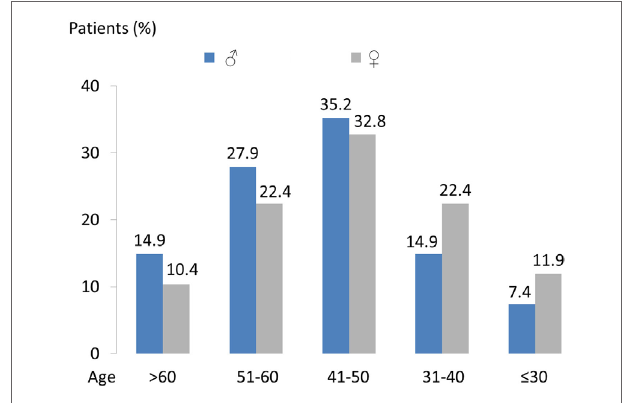
FigUre 3 | Pre/post analysis of days in hospital due to an icD-10-cM F20 diagnosis ( N = 458; July 2013)